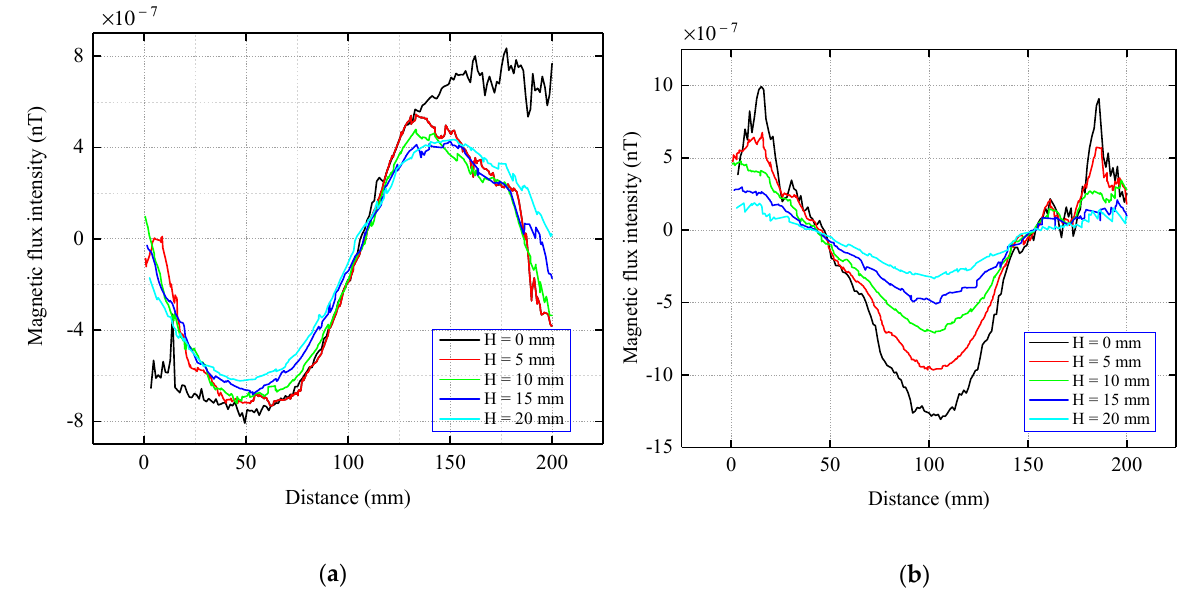
Figure 8. Distribution of the magnetic flux intensity when the stress concentration zone is located at the bottom of the inner wall of the pipe. ( a ) Tangential component. ( b ) Normal component. Table 3. Peak values of magnetic flux intensity under different lift-offs.